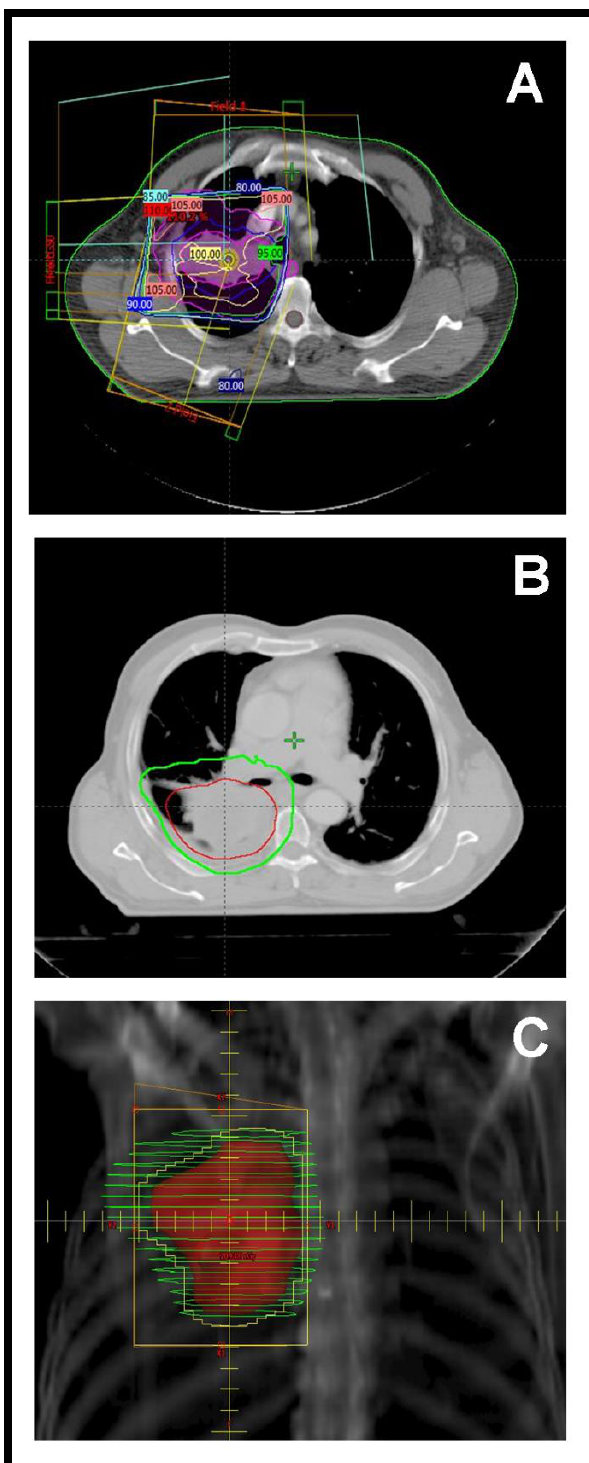
Figure 1. A: Fields arrangement applied for all plans (conventional and adaptive); B: PTV1 (green) and PTV2 (red); C: Volumetric reduction of the PTV . GTV) to <20 Gy and lung V20 to <35%. Esophagus V35 dose was limited to <65%, esophagus V50 dose to <40% and the mean heart dose to <26